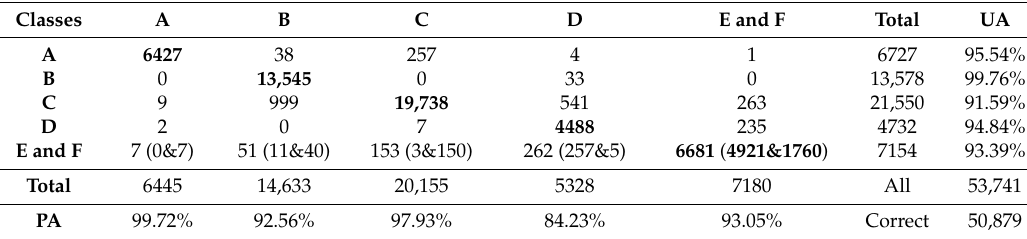
Table 3. Confusion matrix for accuracy assessment (unit: